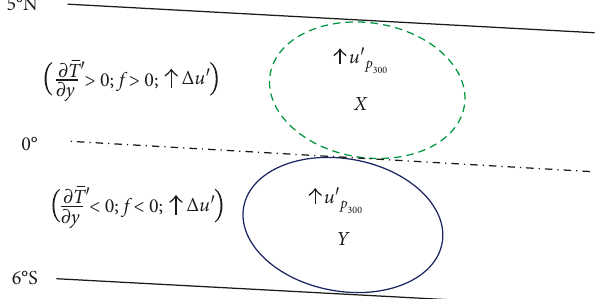
Figure 12: Schematic diagram for the spatial distribution of the horizontal mean layer meridional temperature gradient (HMTG) anomalies within 600–300hPa layer over an area marked with a dashed solid line elliptic circle in Figure 11(a) during anomalous periods of HREs. Schemes X and Y are the latitudinal cross section through the Equator for an area marked with a dashed elliptic circle (Figure